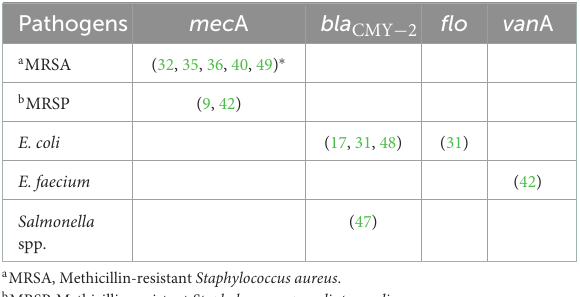
TABLE 6 The antimicrobial resistant genes isolated from bacteria associated with hospital-acquired infections data published between 2000 and